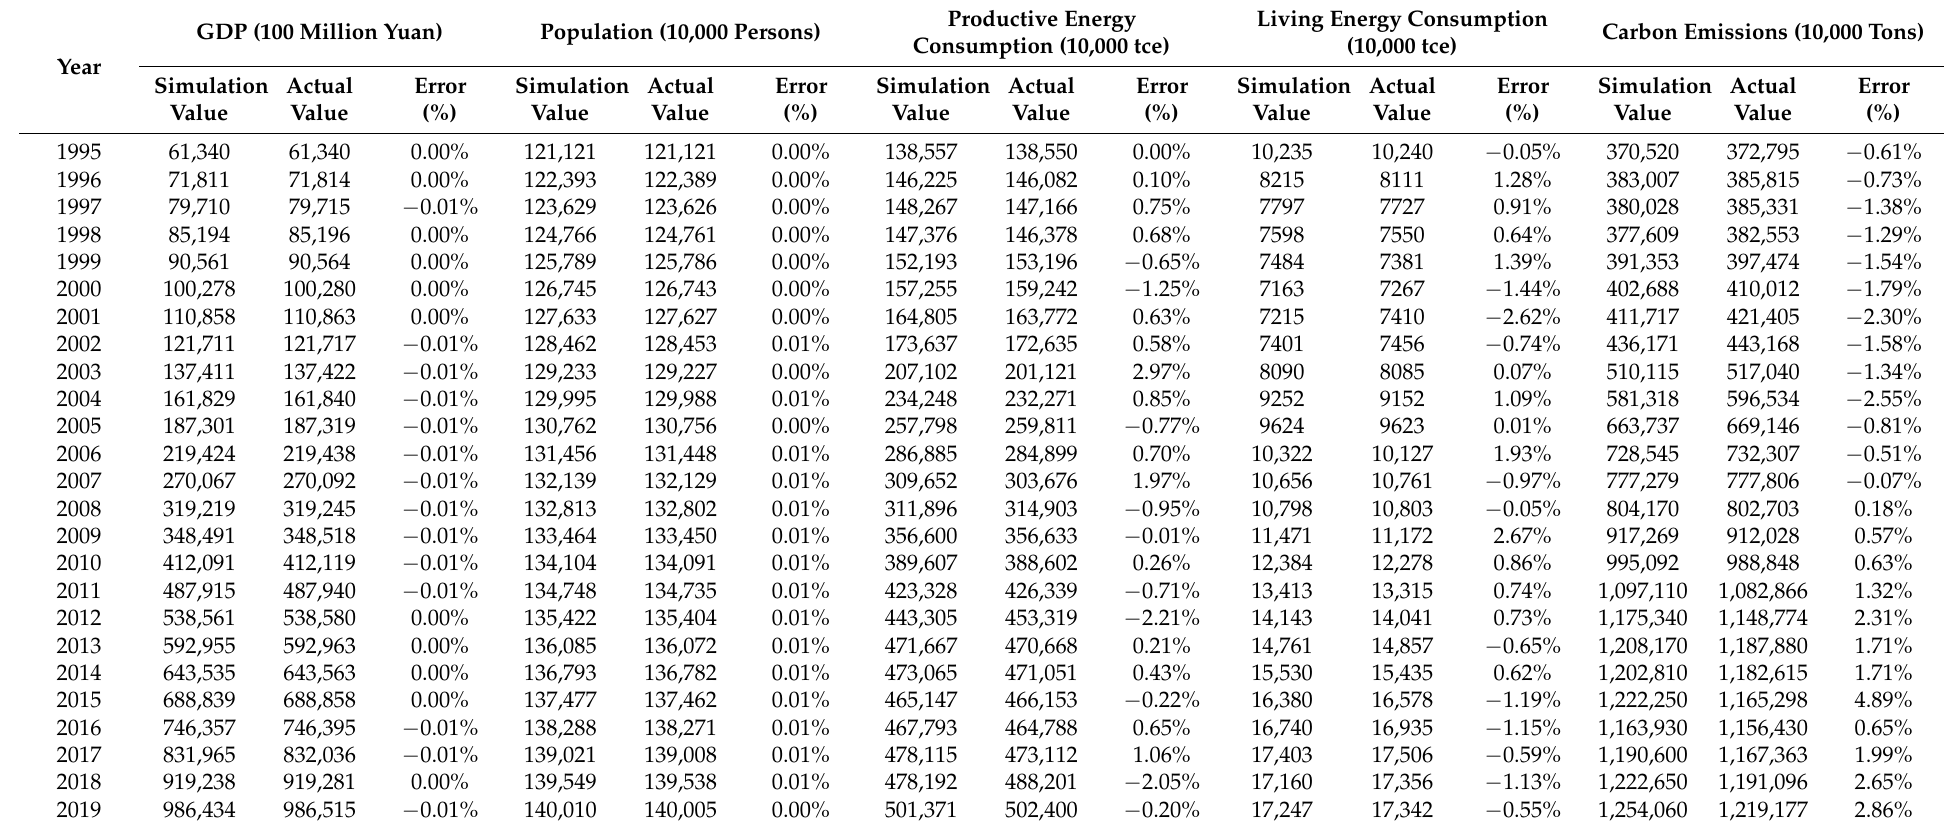
Table 1. Test of main variables of system dynamics model of China’s carbon emissions from 1995 to